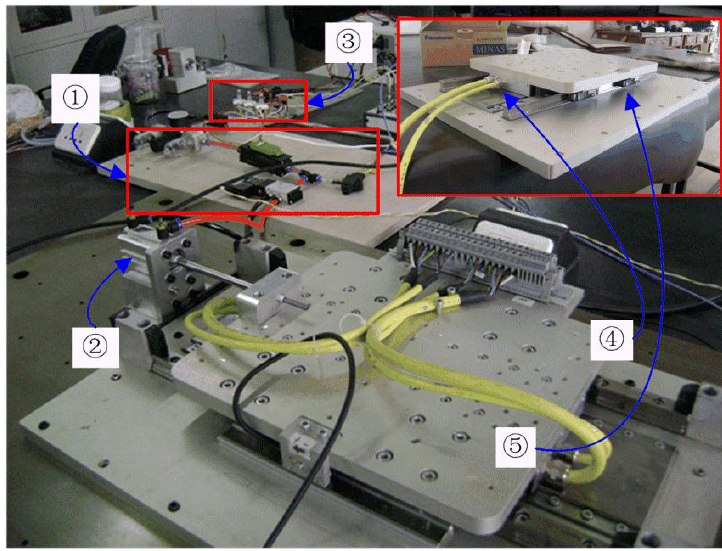
Figure 7. FPELG configuration: ① Gas intake system; ② Gas intake cavity; ③ Load resistance; ④ Linear motor; ⑤ Linear